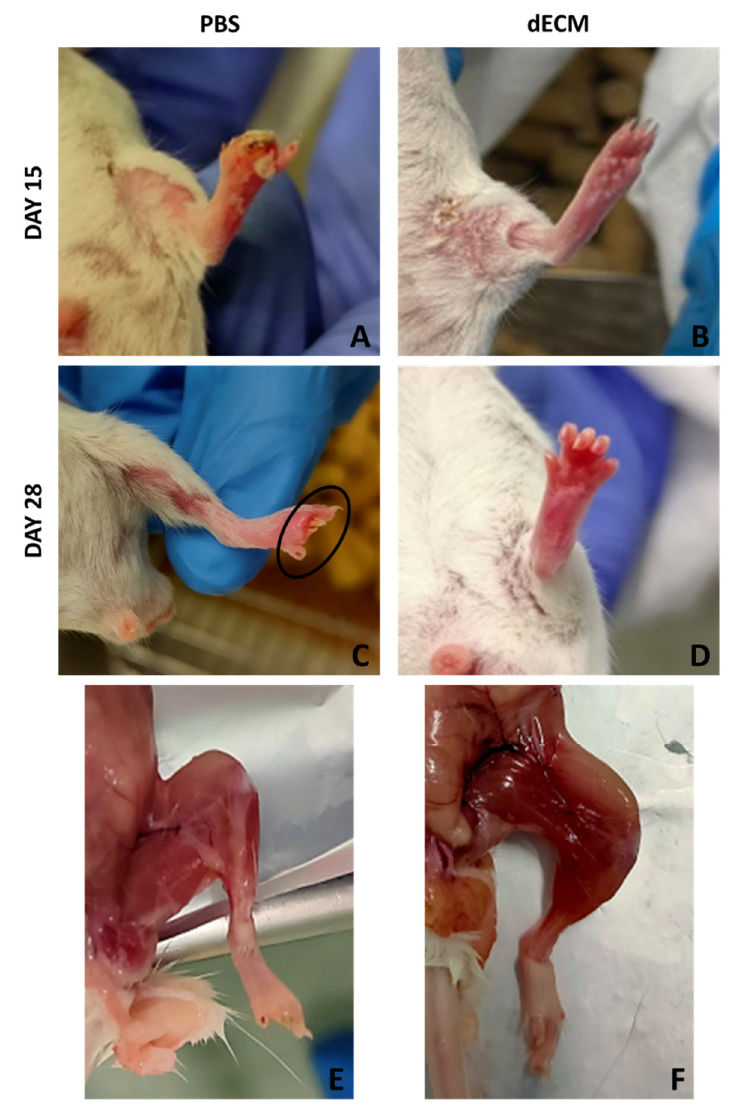
Figure 5. Hind limb ischemia model macroscopic evaluation. ( A , B ) hind limbs of BALB/c mice treated with PBS and dECM at day 15. ( C , D ) hind limbs of BALB/c mice treated with PBS and dECM at day 28. ( E , F ) hind limbs of BALB/c mice treated with PBS and dECM at day 28, after sacrifice. On day 15 and 28, mice were sacrificed for specimen collection for the histological analysis. Figure 6A shows a non-cauterized mouse’s histological specimen of the limb, used as control (to show how the native tissue of limb appears). As shown in Figure 6, PBS alone and collagen induced a significant inflammatory infiltration in the mouse limb, both at 15 (Figure 6B,C) and 28 (Figure 6E,F) days. Interestingly, the 8 mg/mL dECM-treated limb did not show any alteration in the histological architecture either after 15 (Figure 6D) or 28 (Figure 6G) days. Arrows highlight the presence of vessels formed at the injection site, where a substantial neo angiogenesis is present in mice treated with dECM.